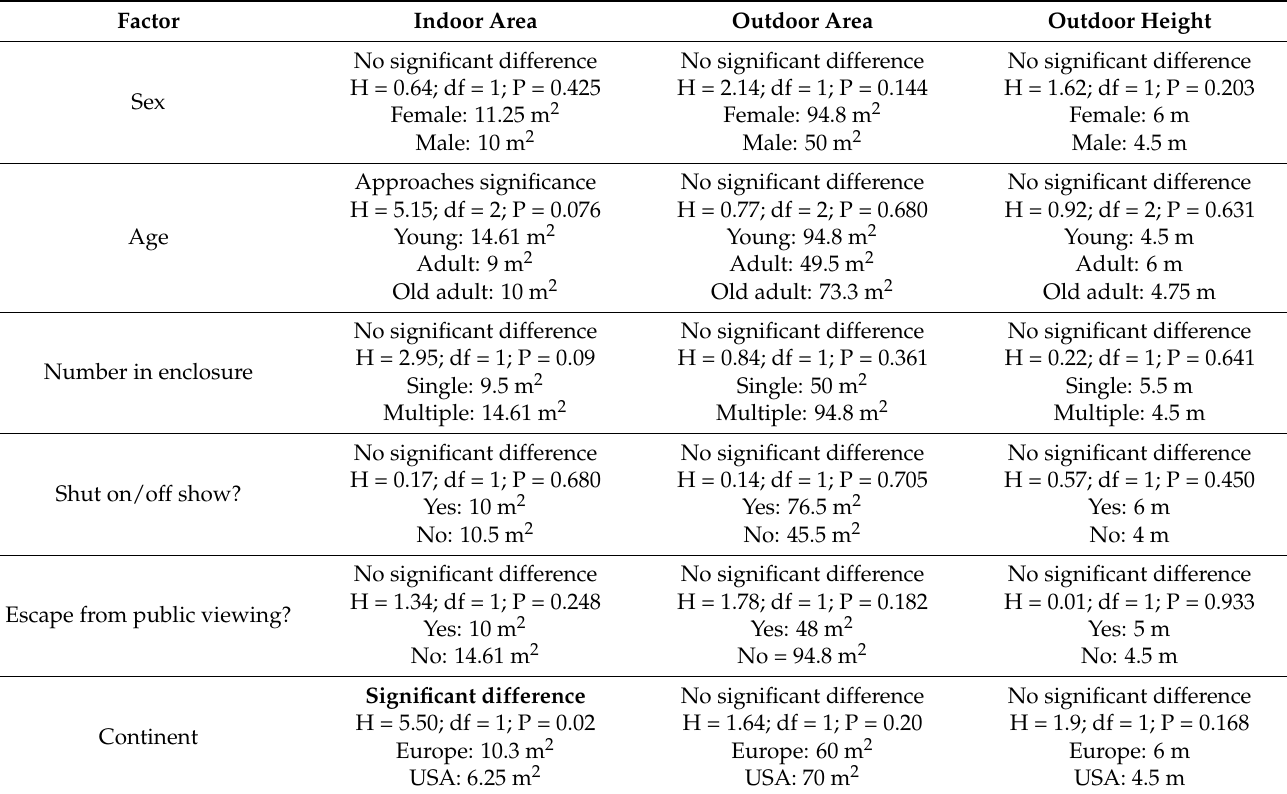
Table 3. Differences in housing of animals in this survey using 36 responses that provided all enclosure measurements and 35 responses for continent (excluding the one response). Factor Indoor Area Outdoor Area Outdoor